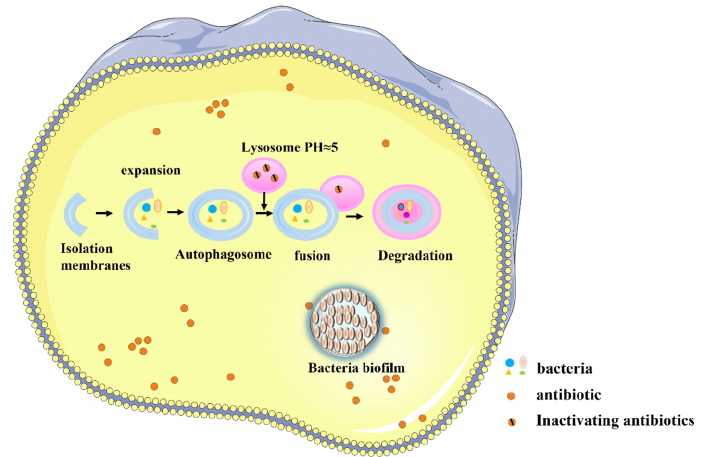
Figure 5. Challenges in the systemic delivery of antibiotics.